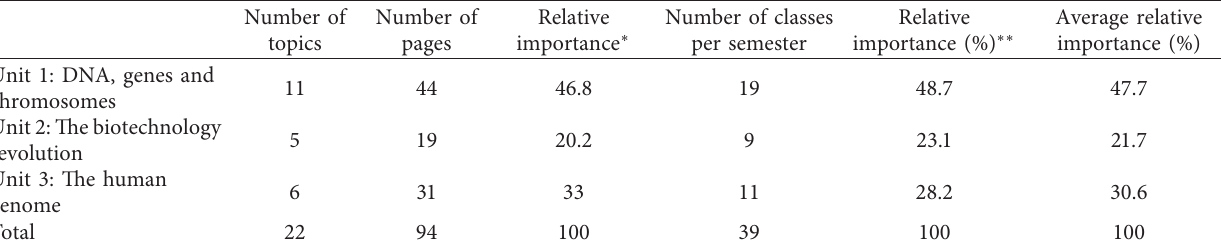
Table 16: Biology textbook topics based on